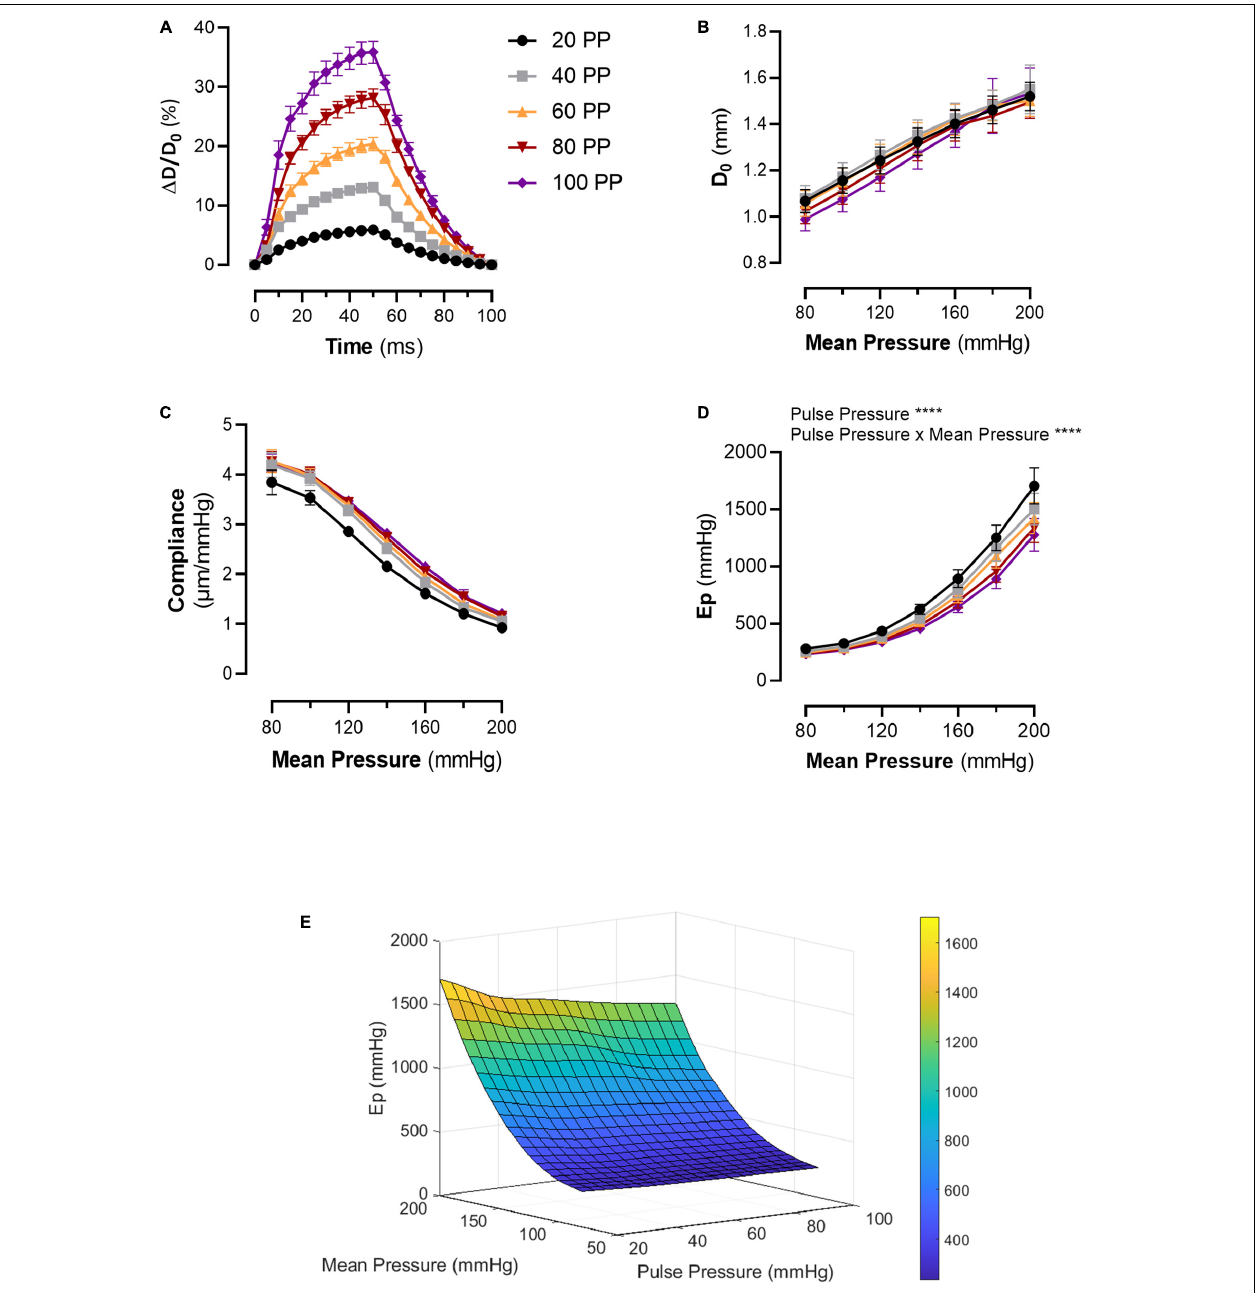
FIGURE 2 | Pulsatile load modulates the pressure-stiffness relationship. (A) Mean distension of a single cycle (100 ms) of thoracic aorta segments at different pulse pressures. Tracings were downsampled to 5 ms intervals. (B) Diastolic diameter is altered by the applied pulse pressure, as expected due to the nature of the setup. (C) The relationship between compliance, pulse pressure and mean pressure. (D) The pressure-stiffness relationship is modulated by the pulse pressure. At low pulse pressures, the pressure-mediated increase in Ep is significantly augmented, while the inverse is true for increasing pulse pressures. (E) Surface plot representing the mean interpolated data. n = 7. Ep, Peterson’s modulus of elasticity; PP, pulse pressure.